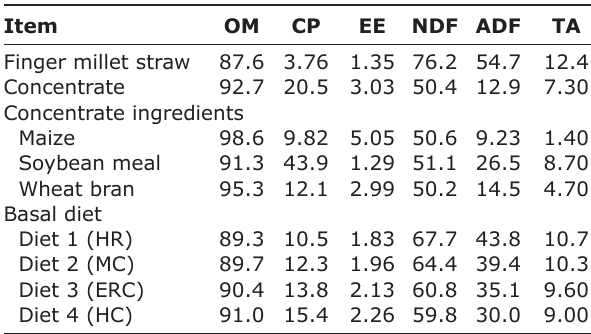
DM: Dry matter, OM=Organic matter, CP=Crude protein (N × 6.25), EE=Ether extract, NDF=Neutral detergent 2 fiber, ADF=Acid detergent fiber, TA=Total ash,